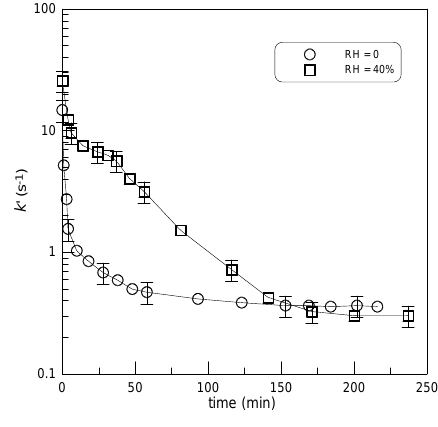
Fig. 4. Dependence of the first order rate constant of NO 2 loss on TiO 2 surface upon exposure time: T = 280K, ∼ = 0.006s − 1 , sample mass ≈ 0.4mgcm − 1 , P = 1–9Torr, J NO 2 [NO 2 ] ∼= 10 13 moleculecm − 3